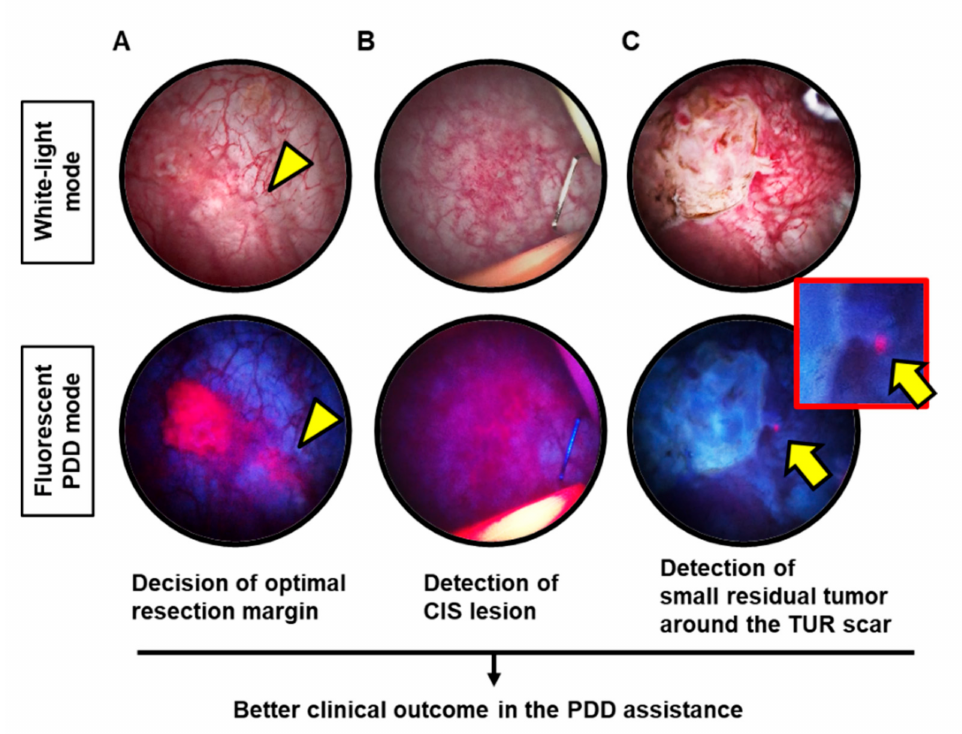
Figure 1. Representative images showing the benefit of using PDD assistance during TURBT. ( A ) A papillary Ta low-grade tumor is examined by both white-light (WL) and photodynamic diagnosis (PDD) modes. A small lesion (yellow arrowhead) spreads in the skirt of the tumor, which is clearly identified by PDD. ( B ) This lesion is equivocal on WL mode, while the PDD mode reveals a flat tumor fluorescing pink under PDD mode. The pathological examination of the biopsy confirmed that this lesion was carcinoma in situ. ( C ) After tumor resection, the PDD mode found a small residual tumor (yellow arrow) close to the resection margin. The additional resection was performed to achieve complete tumor resection. CIS: carcinoma in situ; TUR: transurethral